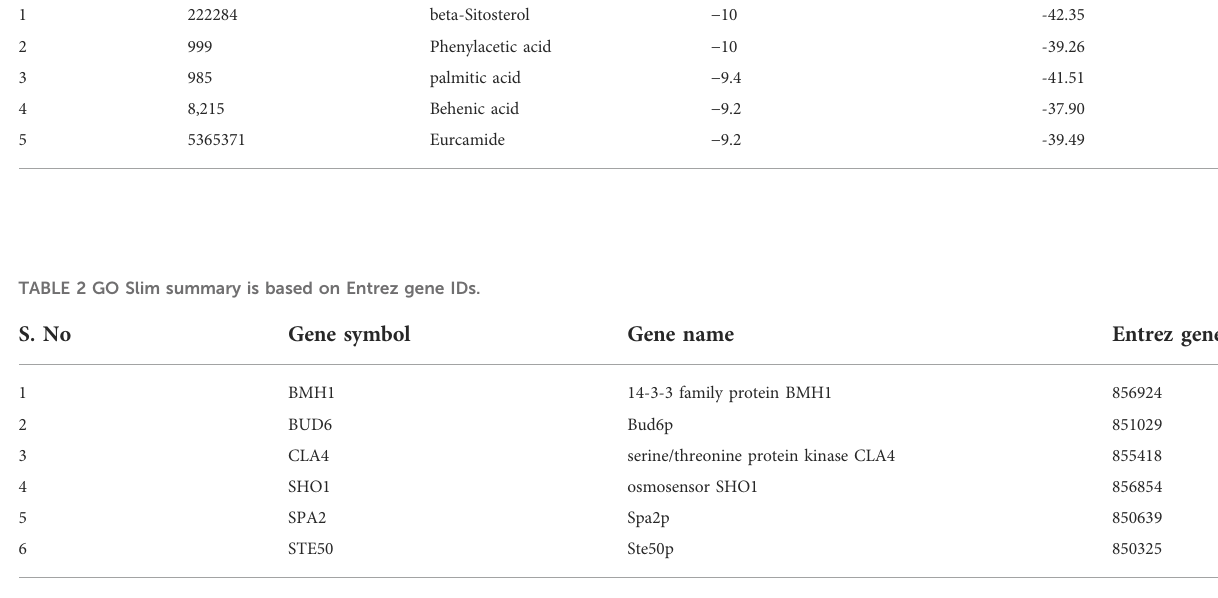
TABLE 1 Docking score of different ligands from B. megaterium with CDC42 protein. S. No